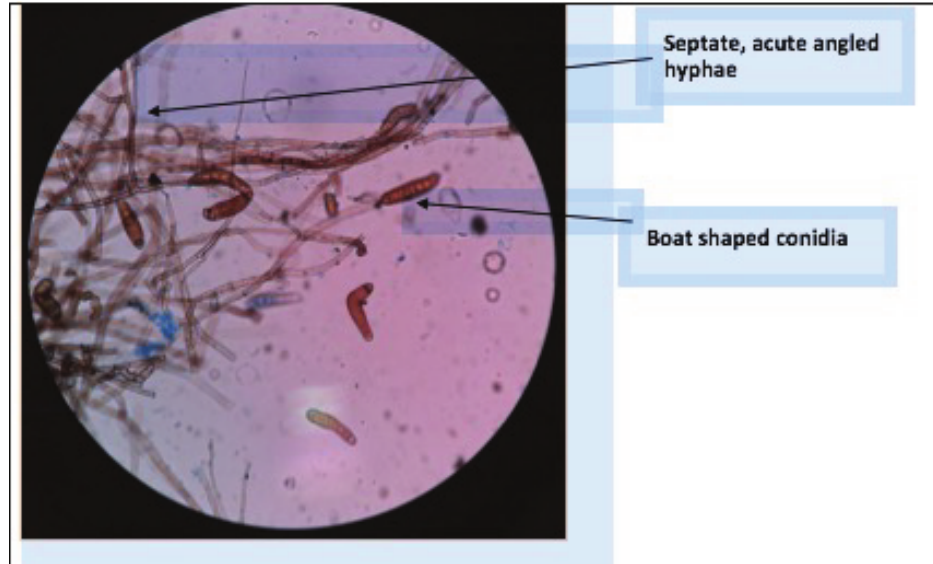
Figure 2. Lactophenol cotton blue staining showing acute angled septate hyphae with boat-shaped conidia.